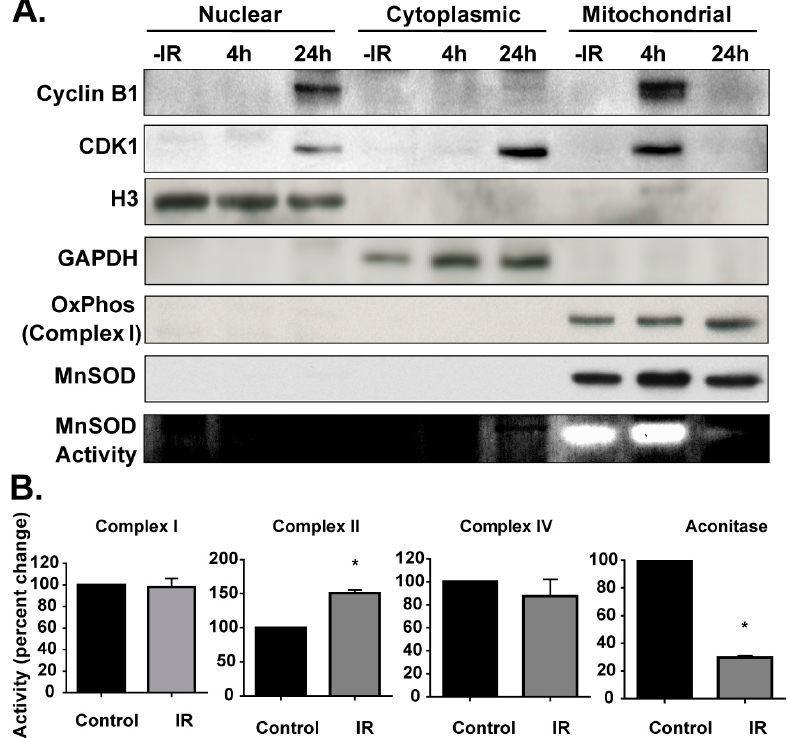
Figure 3. Cyclin B1 coordinates nuclear and mitochondria cross-talk. ( A ) Control (0 h) and 6 Gy irradiated NHFs were harvested at indicated times. Nuclear, cytoplasmic, and mitochondria fractions were isolated using the Qiagen cell fractionation kit, following the manufacturer’s supplied protocol. The purities of various fractions were determined by re-probing the blot with antibodies to histone H3 (nuclear), glyceraldehyde-3-phospahte dehydrogenase (GAPDH) (cytoplasm), oxidative Phosphorylation complex 1 39 kDa subunit (OXPHOS complex 1) and MnSOD (mitochondria). MnSOD activity (bottom panel) was measured by native gel electrophoresis. ( B ) Control (0 h) and 6 Gy irradiated NHFs were harvested at 24 h post-irradiation and mitochondria fractions were assayed for activities of complex I, II, IV and aconitase; asterisks indicate significant differences between control and irradiated cells ( n = 3, p < 0.05).